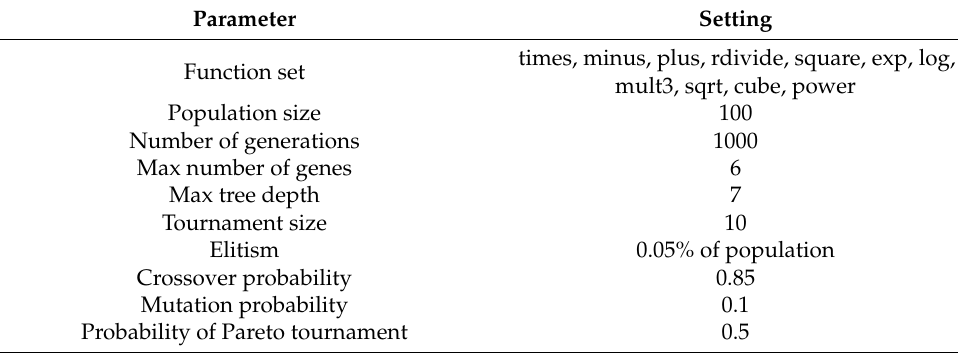
Table 3. Setting parameters for MGGP models.